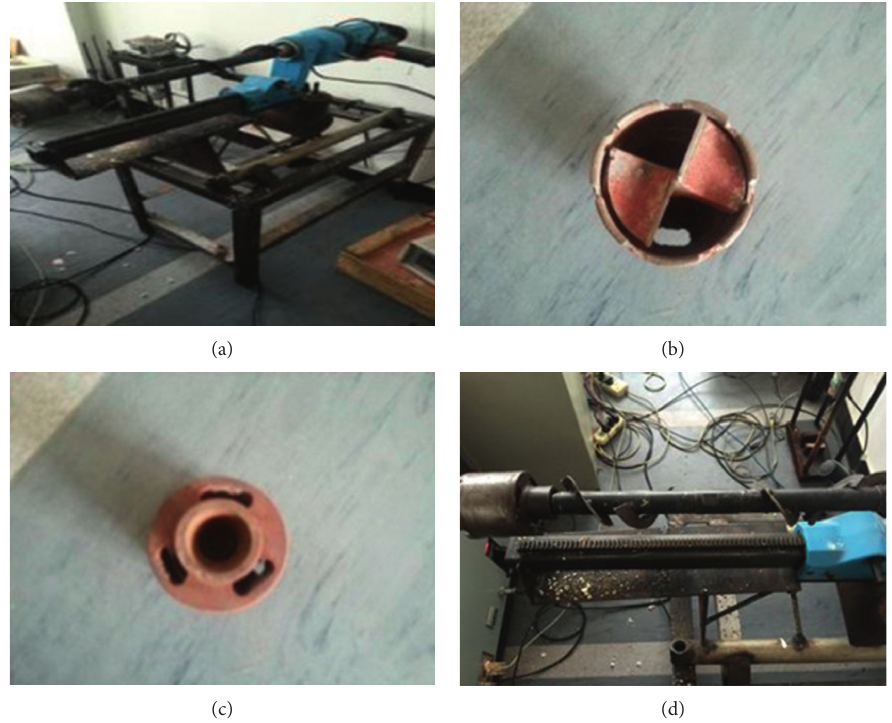
Figure 2: Schematic diagram of experimental device of TBM in structure simulation. (a) Front view. (b) Cutter head. (c) Shield and slag discharge. (d) Guide